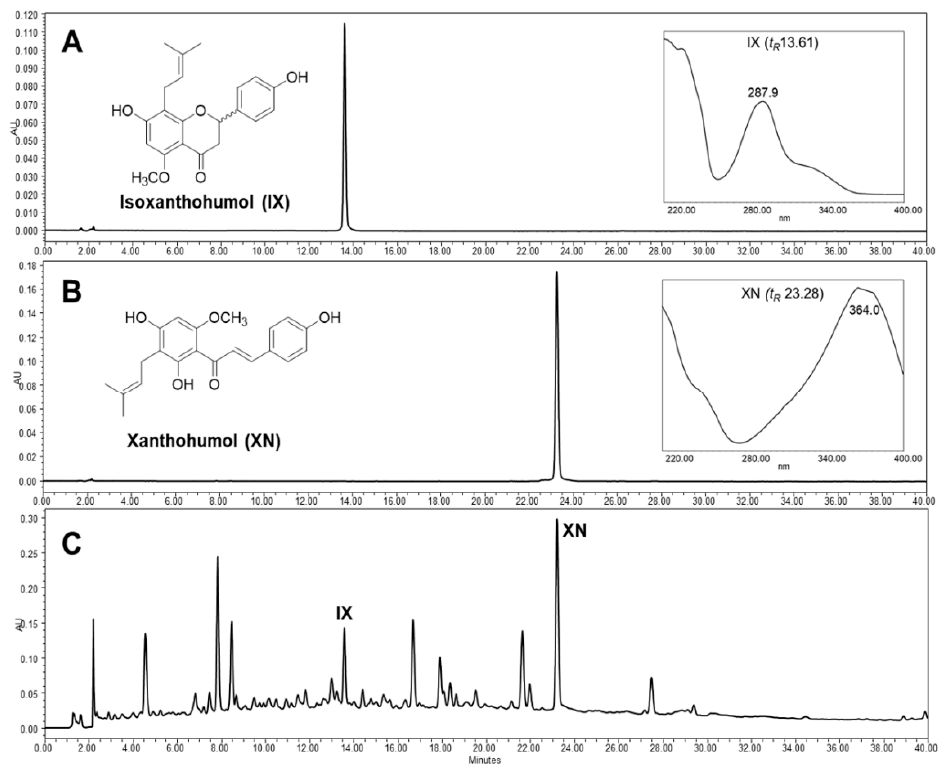
Figure 2. HPLC profiles for prenylated flavonoids and extract from hops: ( A ) isoxanthohumol (IX, 100 µ g / mL), ( B ) xanthohumol (XN, 100 µ g / mL), and ( C ) hop methanol extract (20 mg / mL). HPLC experiments were carried out using a Waters 1525 binary pump, 2707 autosampler, and 2998 photodiode array detector (PDA) detector with a SunFire C18 column (5 µ m, 4.6 × 150 mm, Waters). The chromatographic conditions were as follows: acetonitrile ( A ) and 0.1% formic acid–water ( B ), with 25% to 100% of solvent A for 40 min at flow rate of 1.0 mL / min under 315 nm. Ultraviolet (UV) spectra were reported within a wavelength range of 210–400